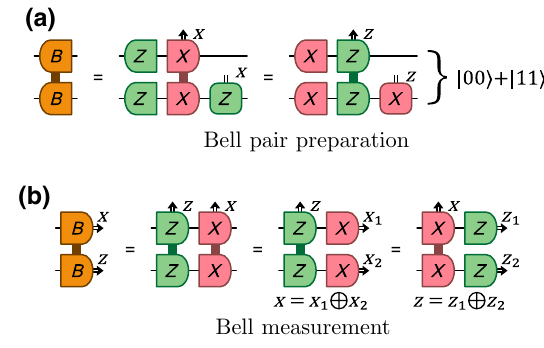
in terms of single- and two-qubit Pauli measurements in depth 1 as given in Fig. 18 [13]. (a) A Bell pair can be prepared from a (horizontal) joint XX measurement of | 00 (cid:4) or a (vertical) joint ZZ measurement of |++(cid:4) , up to Pauli corrections. (b) A destructive Bell measurement can be implemented by a joint XX measure- ment followed by individual Z basis measurements, or by a joint ZZ measurement followed by individual X basis measurements.